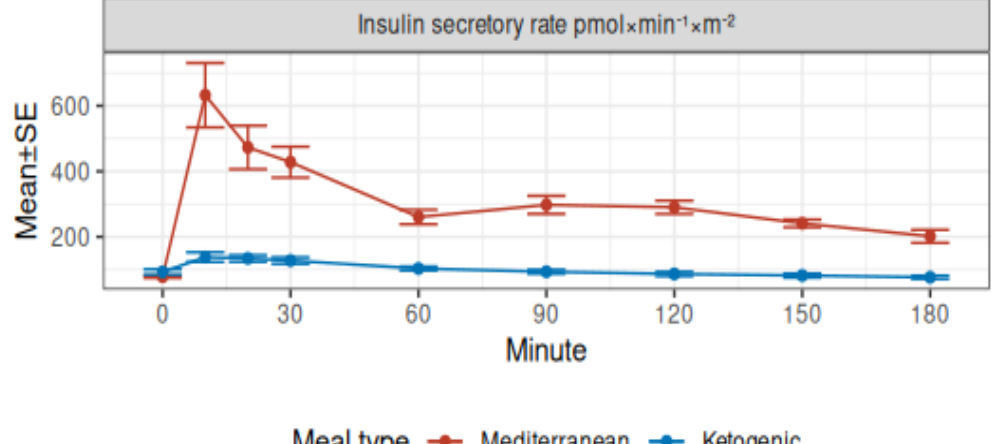
Figure 2. Insulin secretory rate profile by meal type.